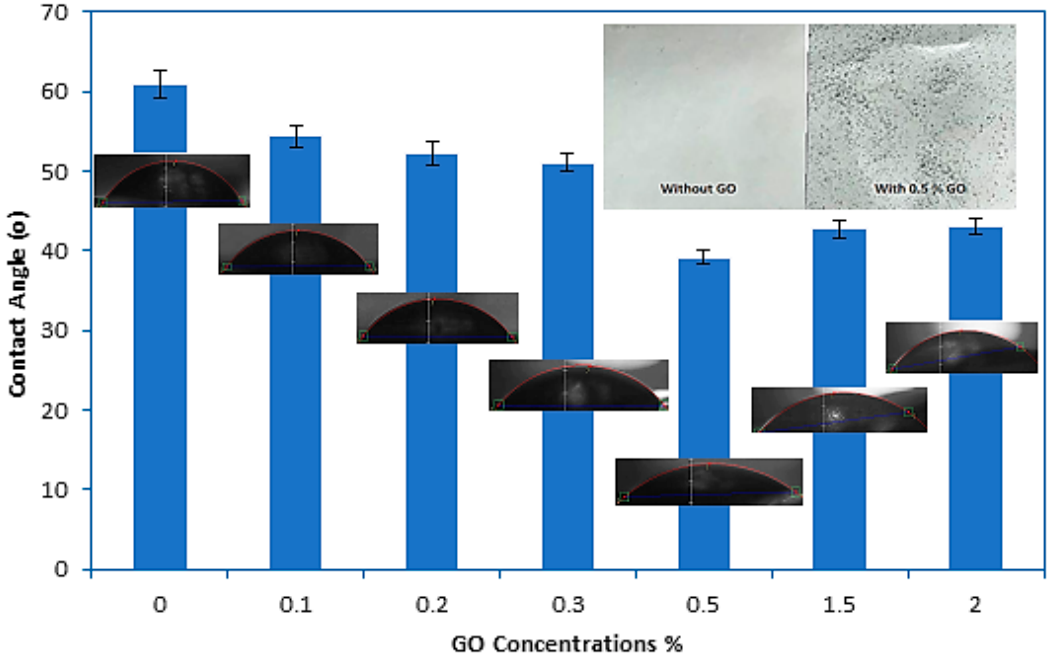
Figure 5. Contact angle measurements for control and GO-modified PES membranes with their top surface photos. The bar height is the average of five contact angle measurements and the error bars represent ± one standard deviation.